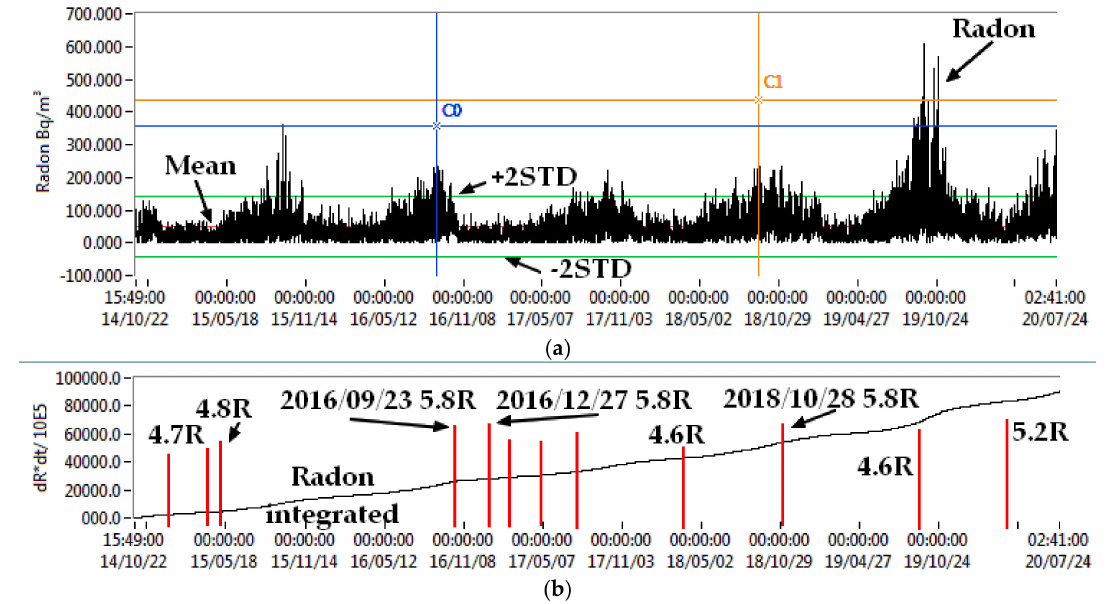
Figure 3. Radon evolution in Bisoca station: ( a ) radon time series, +/ − 2STD standard deviations method, mean value; ( b ) integral of radon and correlation with